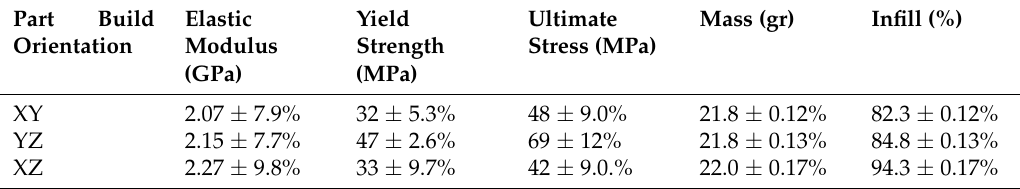
Table 5. Elastic modulus, yield strength, ultimate strength, mass, and infill for each